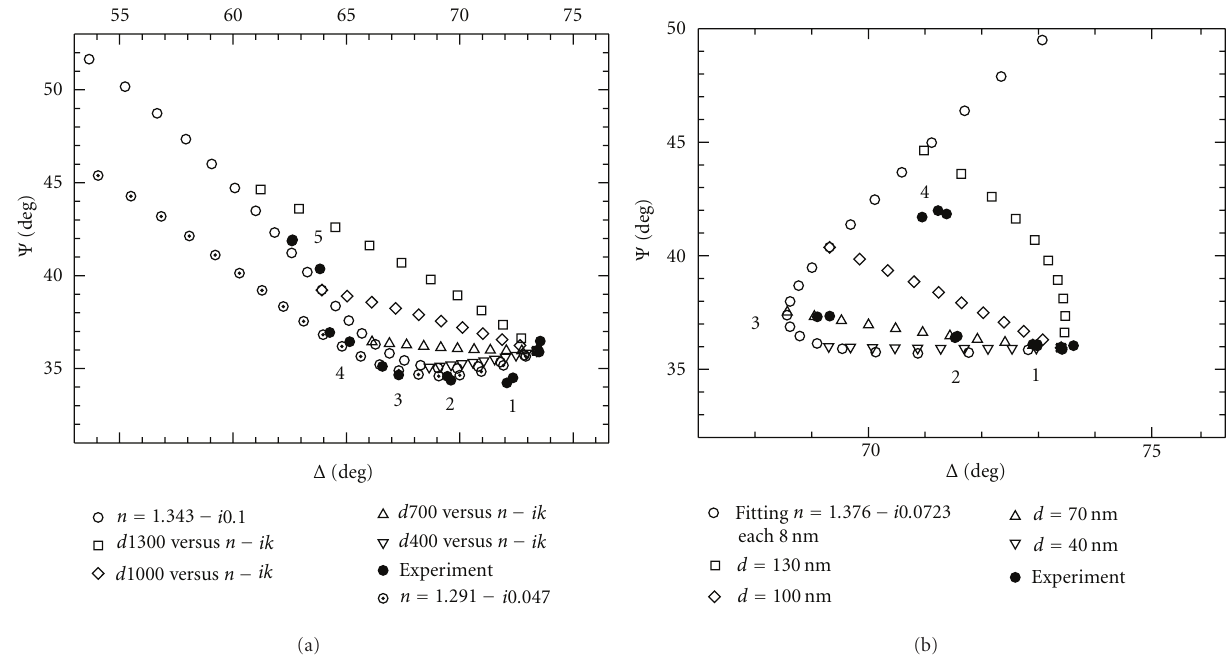
Figure 9: Enlarged plots of Ppy layers showing Δ / Ψ values corresponding to the first cycles shown in Figure 3. ( • ) experimental points, (a ) Ea = 1.2 V, (b ) Ea = 1.4V. The figures correspond to number of cycles. Open points corresponds to di ff erent growing models: ( (cid:6) , (cid:5) ) increasing d holding n and k fixed; ( (cid:2) , ♦ , (cid:4) , ∇ ) decreasing both n and k for di ff erent d fixed values, namely d = 130, 100, 70 and 40 nm,